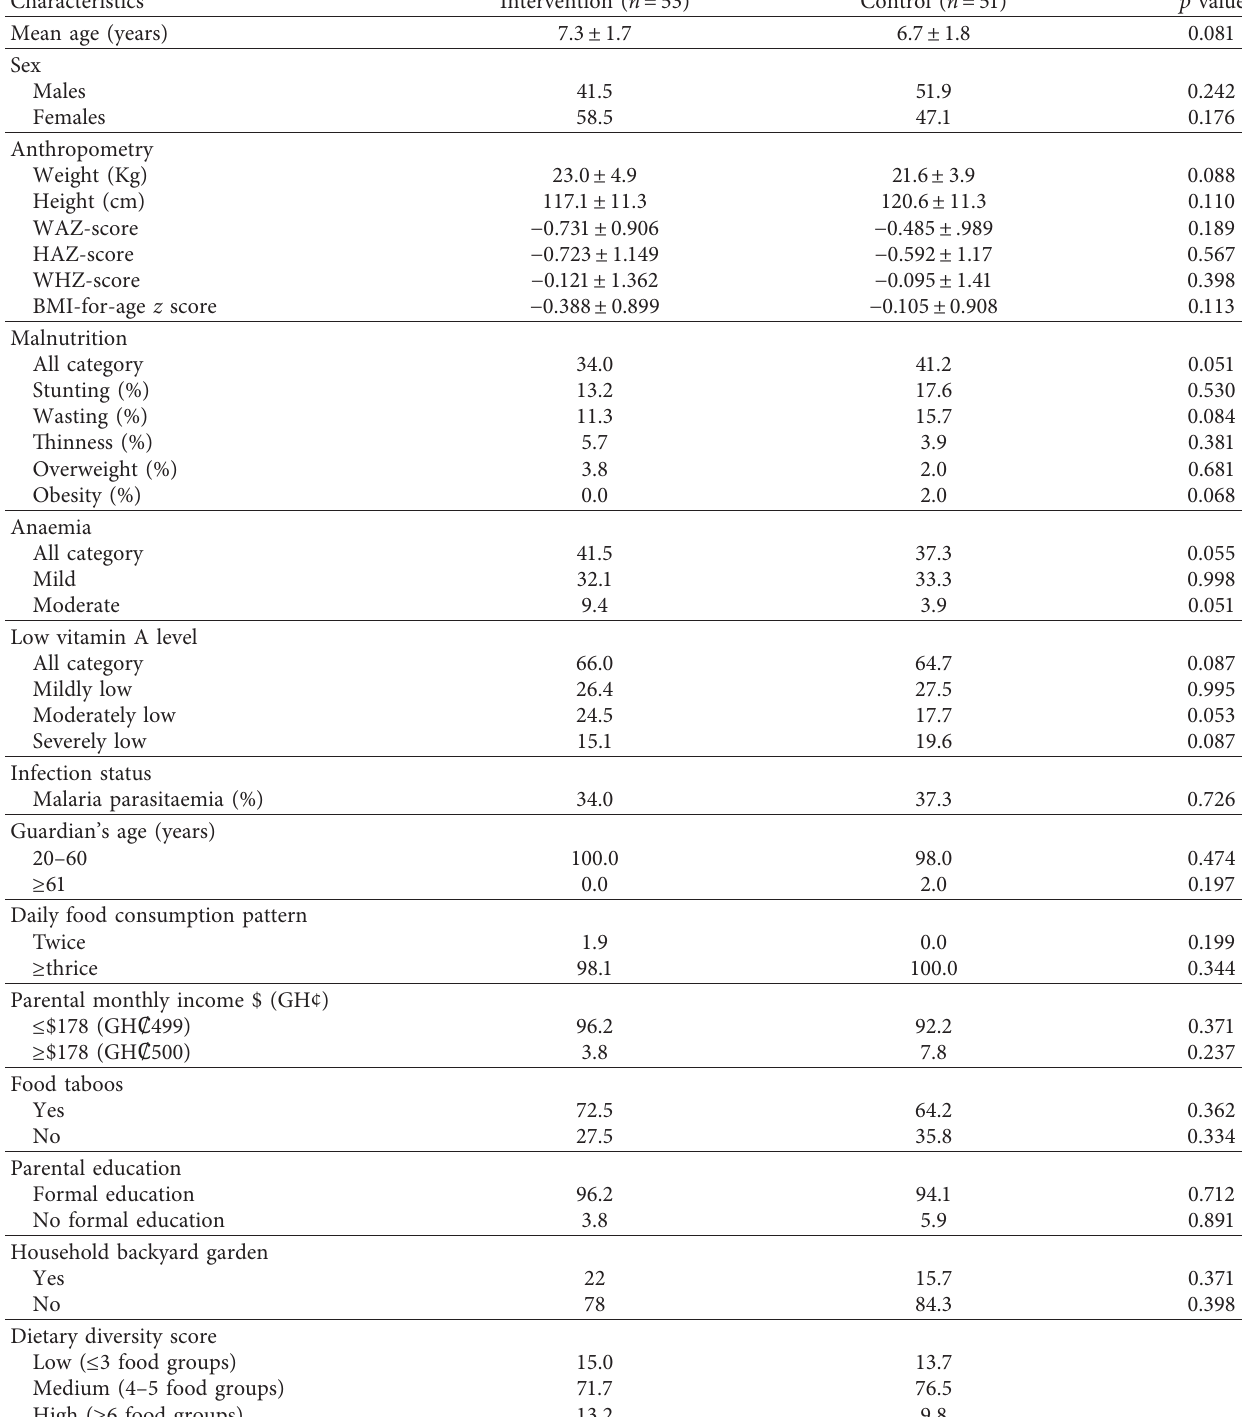
Table 1: Background characteristics of participants by the study